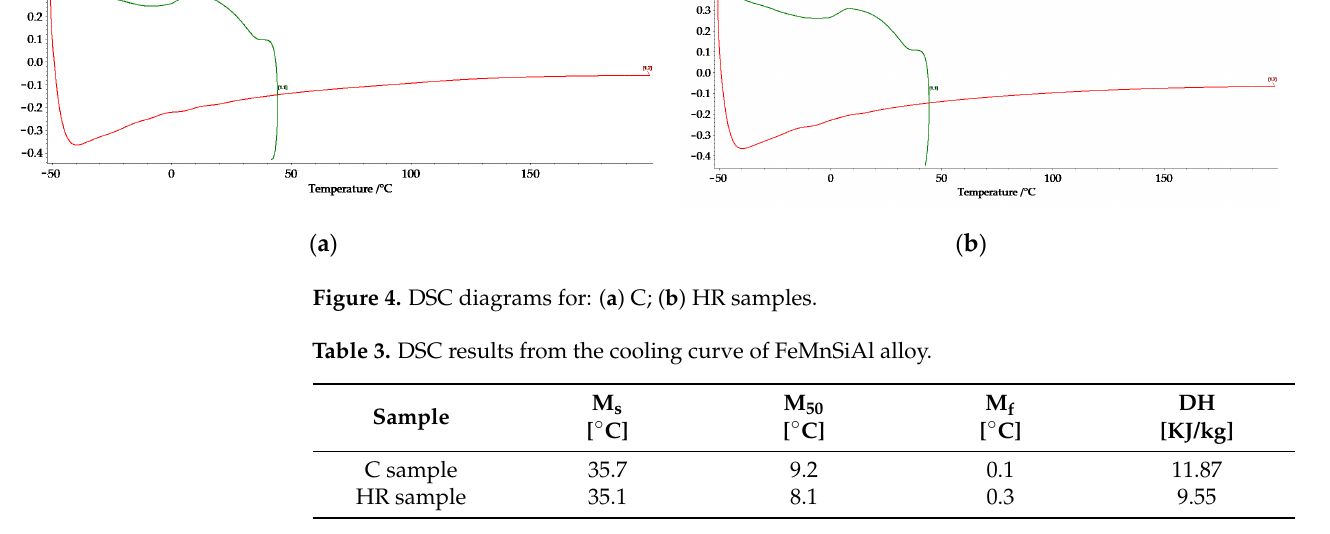
Table 3. DSC results from the cooling curve of FeMnSiAl alloy.